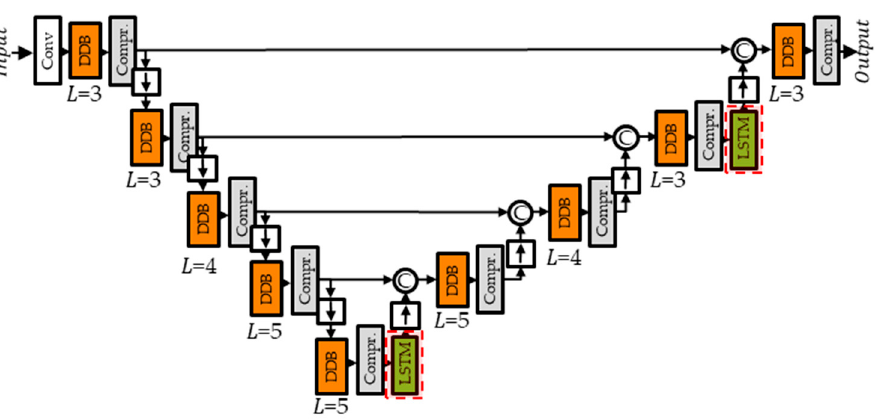
Figure 2. The architecture of multi-scale dilated time-frequency DenseNet with LSTM (MDilDenseLSTM). This architecture is in the full band of multi-band MDilDenseLSTM (MMDilDenseLSTM). The red dashed box represents the recurrent neural network (RNN)-based architecture. DDB: dilated dense block, LSTM: long short-term memory.